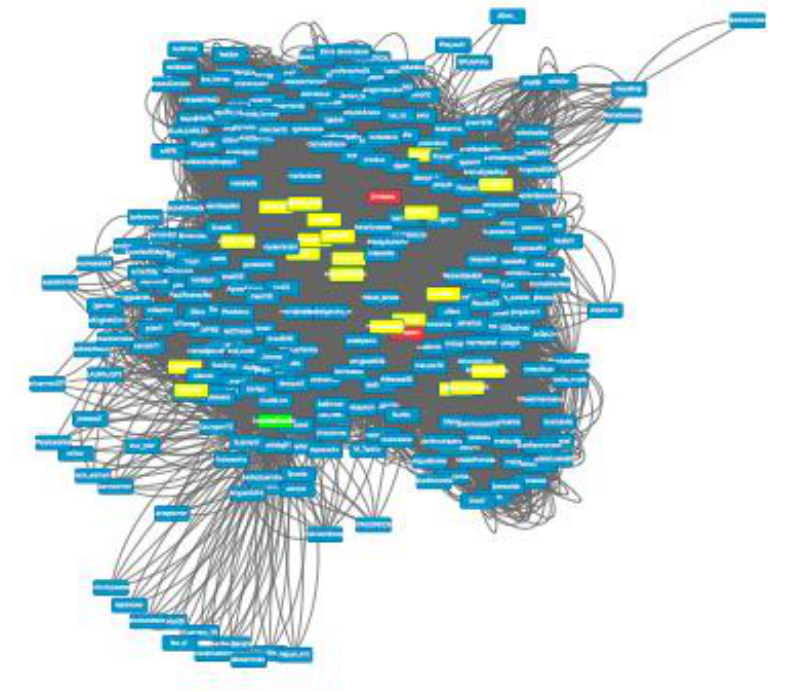
Figure 1 . Network representation of participants (nodes) and their connection, either as followers and/or followed members